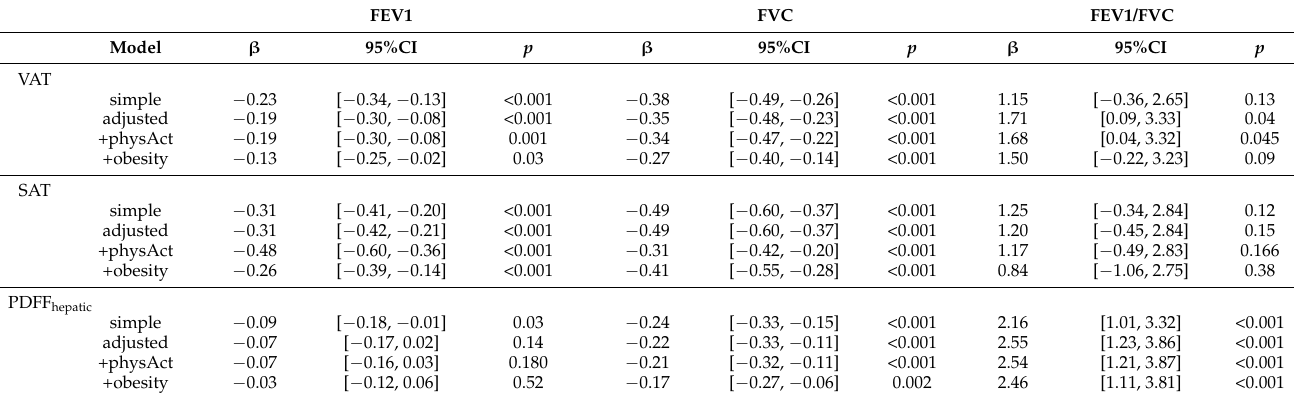
Table 3. Associations of MR derived adipose tissue with outcome FEV1, FVC and FEV1/FVC. FEV1 FVC